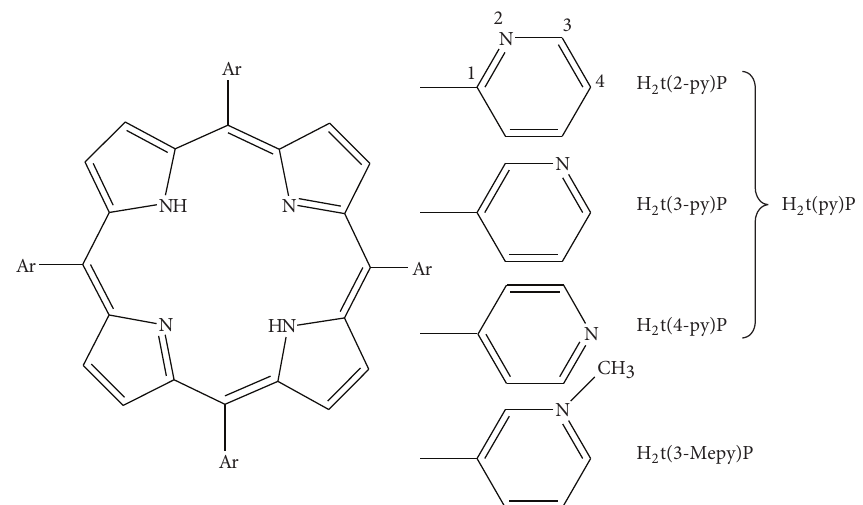
F 1: e porphyrins used in this